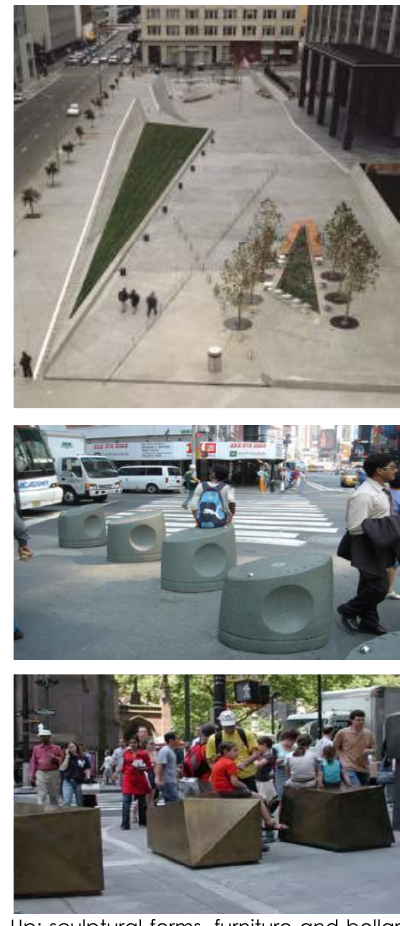
Figure 6. Up: sculptural forms, furniture and bollards serving as restrictive elements. San Francisco Federal Building (FEMA, 2007); middle: Times Square Tower, down: Wall Street, New York City, Rogers Marvel Architects (Phifer, 2005;